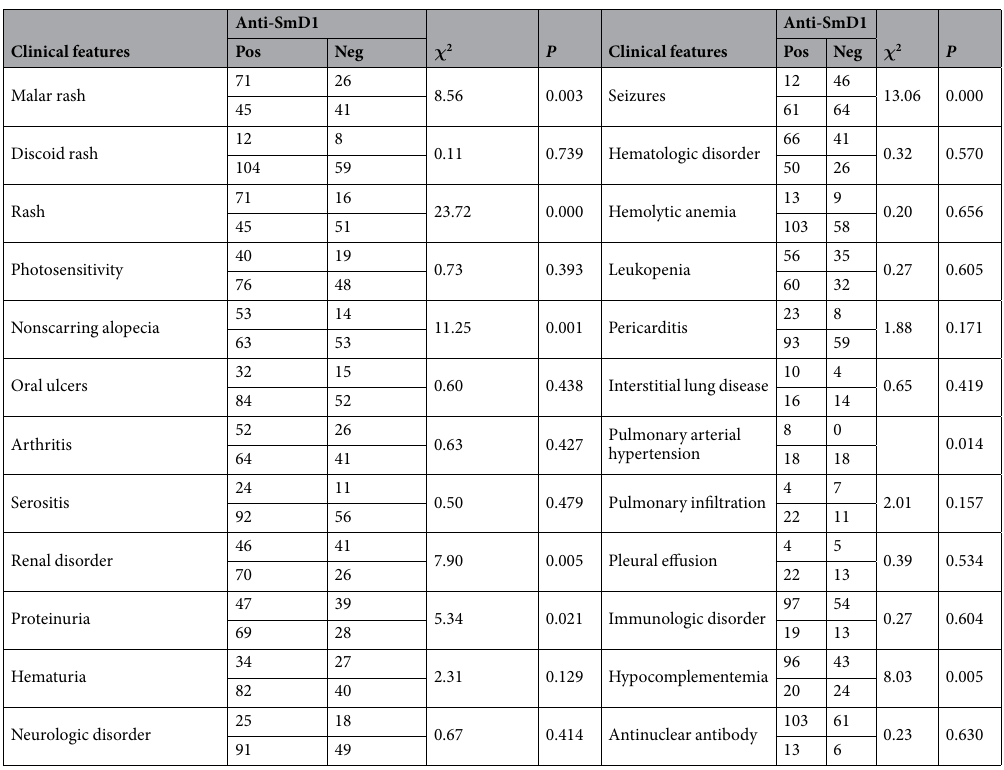
Table 3. Associations between SLE-related clinical features of 183 patients with active SLE and anti-SmD1